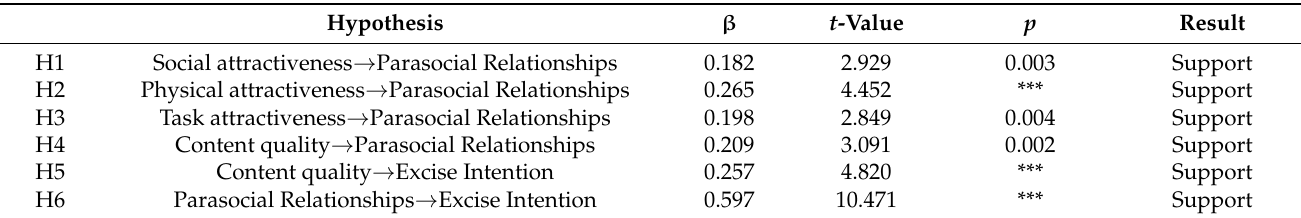
Table 6. Unstandardized direct, indirect, and total effects of the hypothesized model.